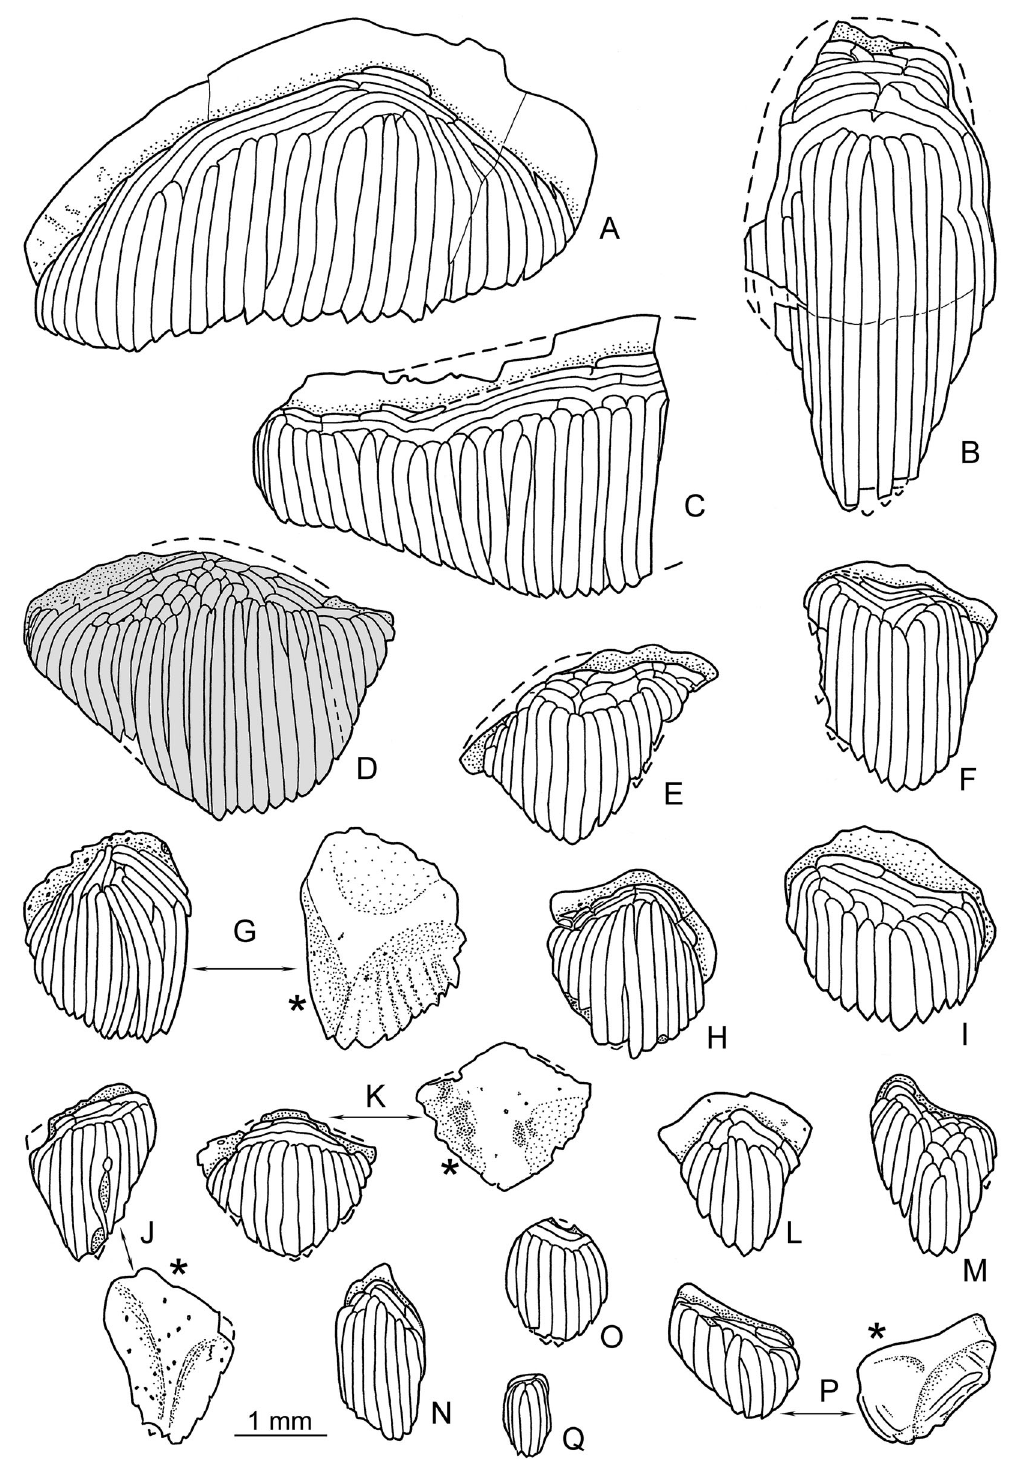
Fig. 4. Archegonaspis lindstroemi Kiaer: A–C , E–Q , set of scales; D , scale possibly from A. integra (Kunth). A, GIT 408-21; B, GIT 408-23; C, GIT 408-22; D, GIT 408-24; E, GIT 408-25; F, GIT 408-26; G, GIT 408-27; H, GIT 408-28; I, GIT 408-29; J, GIT 408-30; K, GIT 408-31; L, GIT 408-32; M, GIT 408-33; N, GIT 408-34; O, GIT 408-35; P, GIT 408-36; Q, GIT 408-37. Scale bar = 1 mm. Location : Tabuska (Vishnevaya Gora) section, locality 85-042, the Central Urals, Tabuska Beds either of the lower P ř idoli (Shujskij 1981; Shurygina et al. 1981) or upper Ludlow level (Modzalevskaya & Märss 1991). The asterisk (*) indicates the basal view of the scales connected with a line; shadow in D is for another species in the set as given